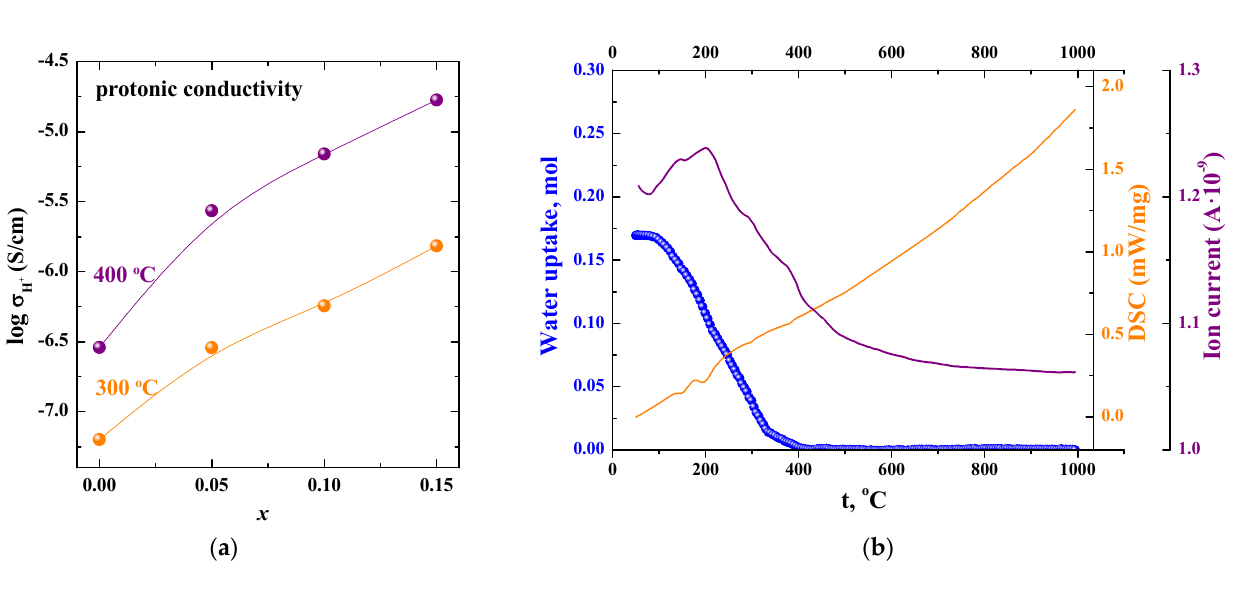
Figure 6. The concentration dependencies of protonic conductivity for the solid solution Figure 6. BaLa 1.9− x Sr x Gd 0.1 In 2 O 7−0.5 x at 300 °C and 400 °C ( a ); the results of TG (blue line), DSC (orange line) BaLa 1.9 − x Sr x Gd 0.1 In 2 O 7 − 0.5 x at 300 ◦ C and 400 ◦ C ( a ); the results of TG (blue line), DSC (orange and MS(H 2 O) (violet line) investigations for the composition BaLa 1.8 Sr 0.1 Gd 0.1 In 2 O 6.95 ( b ).